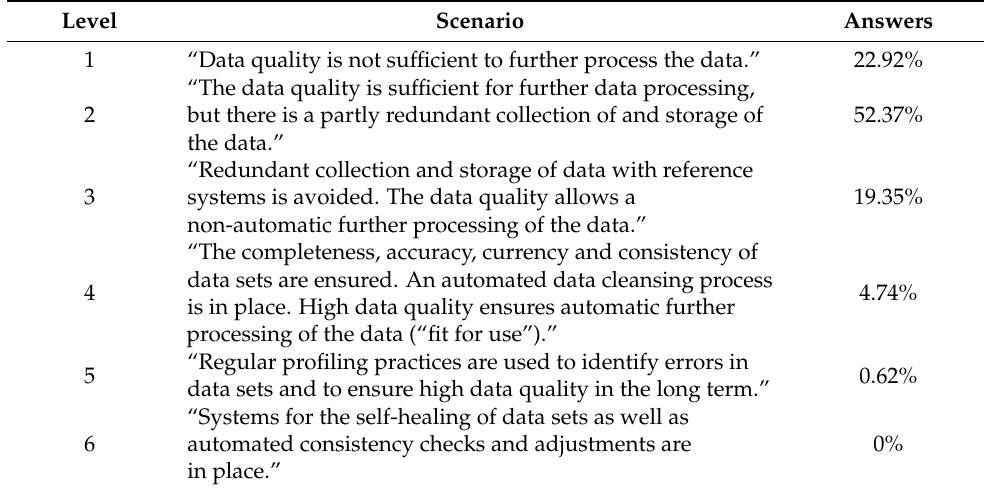
Table 1. Results for the capability “data